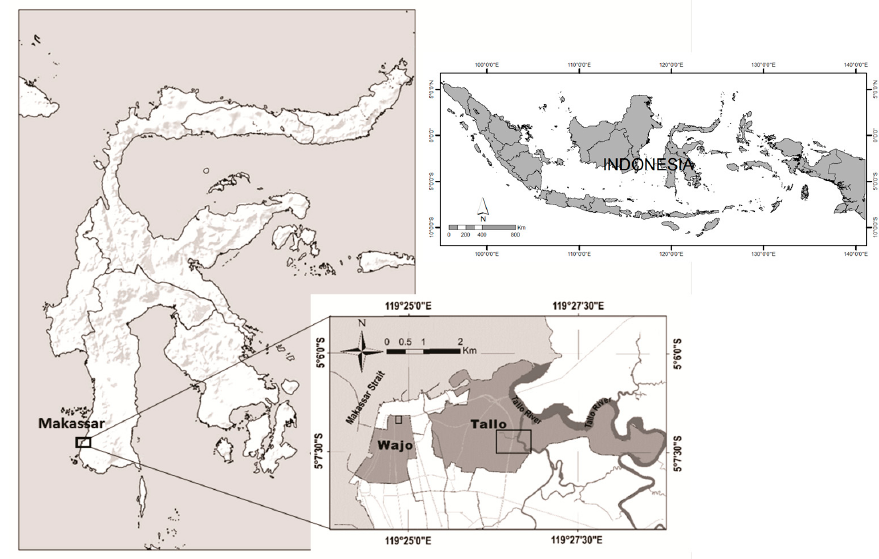
Figure 1. Sulawesi island, Indonesia, the locations of urban gold workers (two square boxes) in Tallo and Wajo sub-districts, Makassar.